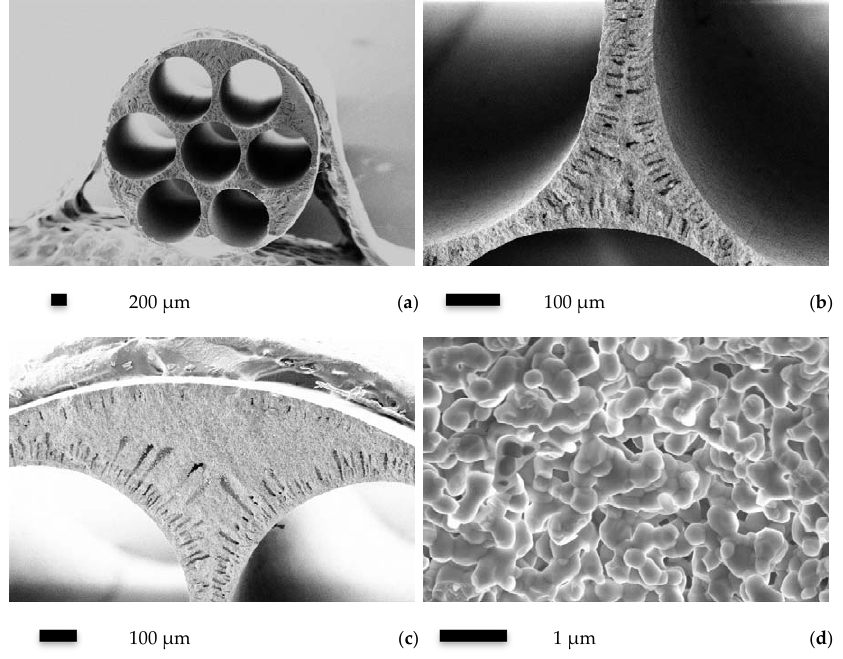
Figure 1. Microstructure of the Al 2 O 3 ‐ YSZ seven ‐ channel capillary membrane sintered at 1400 °C: ( a ) whole view of the cross section; ( b ) cross ‐ sectional view of the internal wall between channels; ( c ) cross ‐ sectional view of the outer wall and ( d ) micro ‐ structure in the sponge ‐ like region. Membranes 2016 , 6 , 5